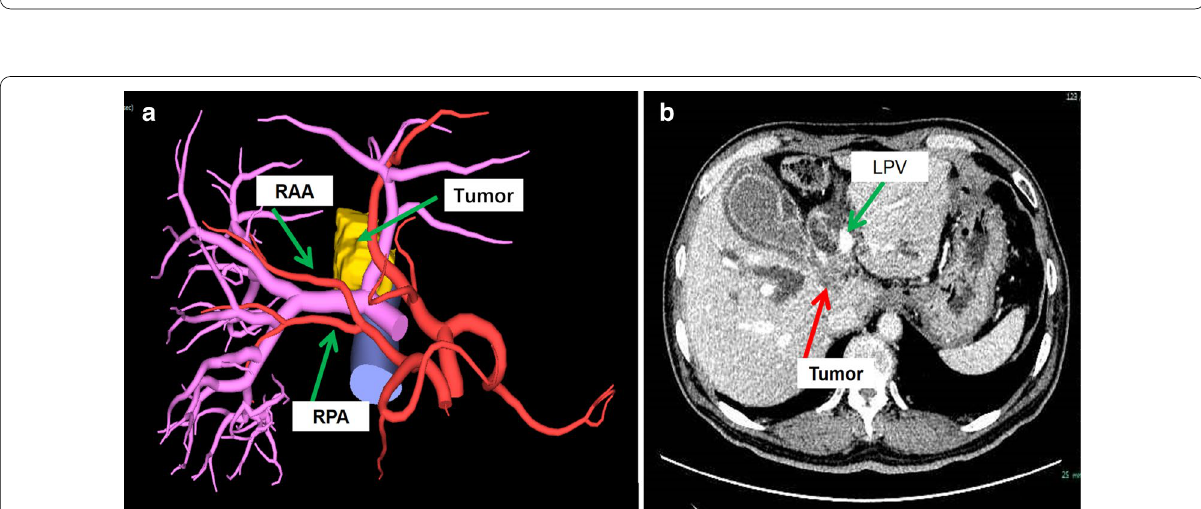
Fig. 2 Location of tumor and vessels: a the three-dimensional reconstruction of the tumor and artery, the right branch was closely related to the tumor, and the right hepatic artery was from the superior mesenteric artery and was not affected. b The CT scan which shows the tumor was located at the bifurcation of the portal vein, the left branch of the portal vein was compressed. RAA right anterior hepatic artery, RPA right